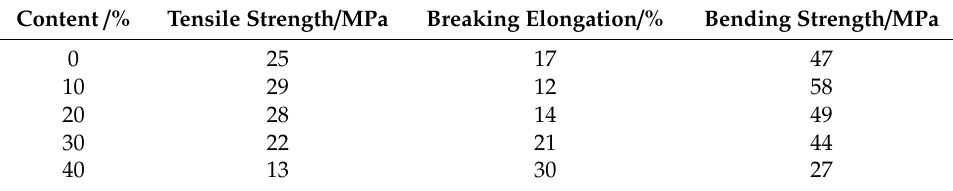
Figure 3. Influence of the modification ratio on the mechanical properties of hybrid resins. Table 2. Mechanical properties of photosensitive resin.